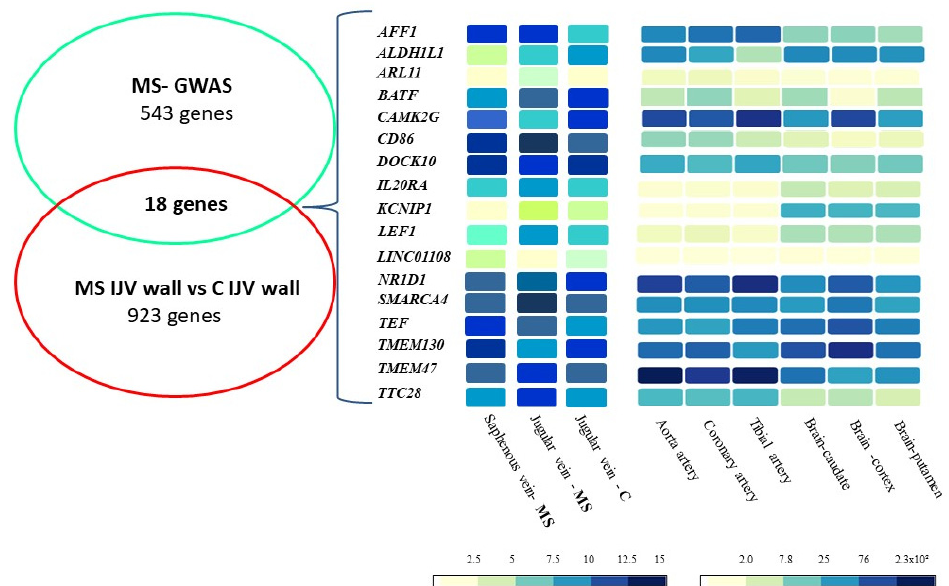
Figure 1. Schematic representation of the mRNA expression levels of MS-GWAS genes in vascular and brain tissues. Data from venous tissues were obtained by transcriptome analysis of IJV and SV from MS patients and from IJV of controls. Data from arteries and brain tissues were retrieved from GTEx portal. The expression levels are reported as log 2 expression values (Table 1) for IJV and saphenous vein, or as transcript per million (TPM) for arteries and brain tissues, according to the color scales reported below the figure. For the ncRNA LOC00130476, no expression data in vascular or brain tissues are reported in GTEx portal.